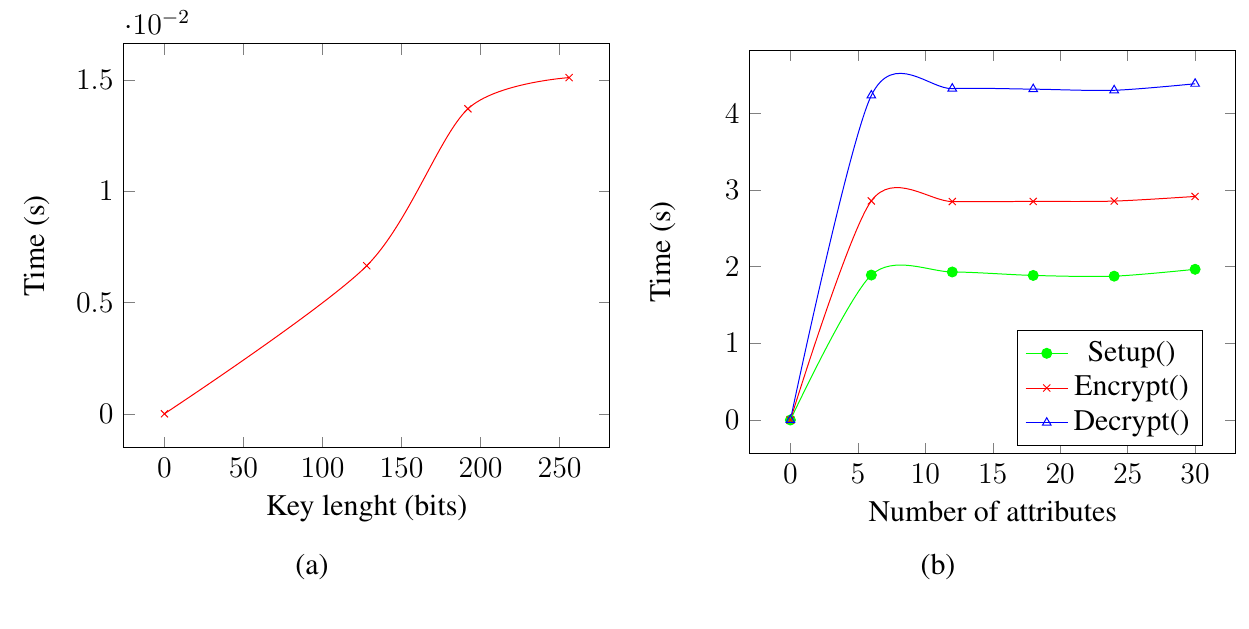
Execution time: ( a ) AES; ( b ) ciphertext policy attribute-based encryption